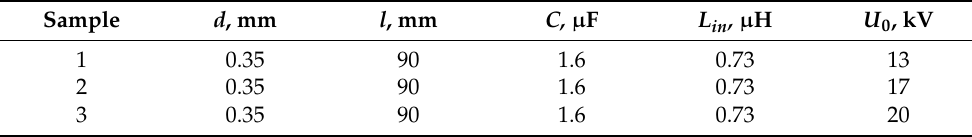
Figure 1. Schematic diagram of the EEW setup. Table 1. Operating Parameters for Obtaining Al